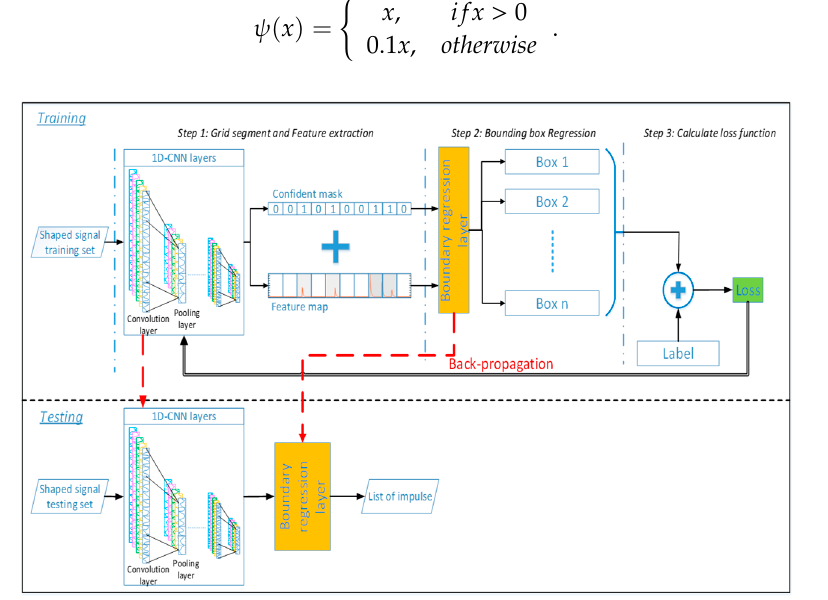
Figure 4. The deep learning flexible boundary regression (DLFBR) impulse detection algorithm.